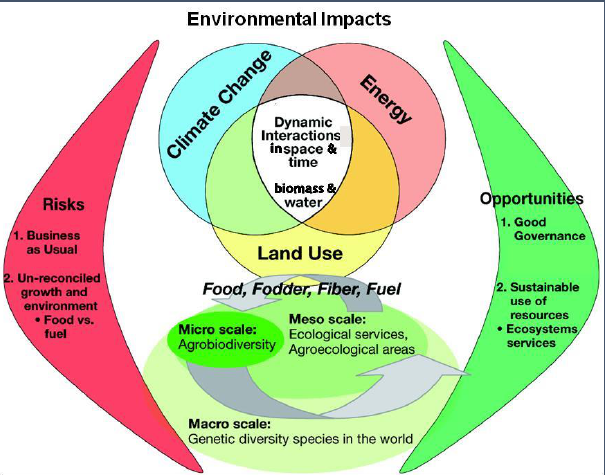
Figure 2. Nexus position of biobased economy options in climate, land use and energy, with impacts on macro-, meso- and micro-scale that depend on the way biobased value chains are implemented (derived from: [1]).